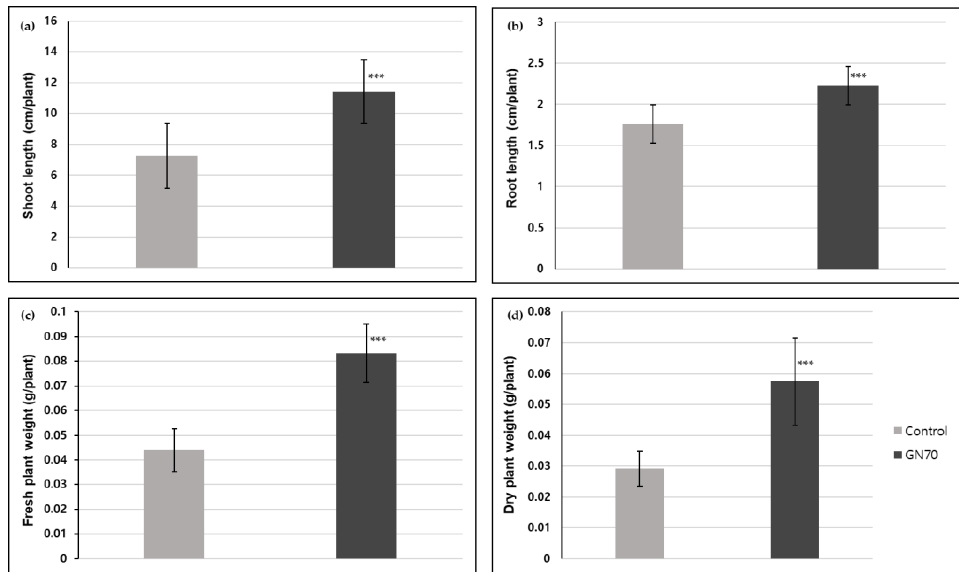
Figure 3. Effect of GN70 inoculation on rice seeds (IT267968) in vitro after 14 days of incubation. On average, shoot length ( a ) and root length ( b ) increased by 57.7% and 26.7%, respectively. Fresh plant biomass ( c ) increased by 89.6% and dry plant biomass ( d ) by 97.1% (average from 60 explants ± SD, *** p ≤ 0.01).